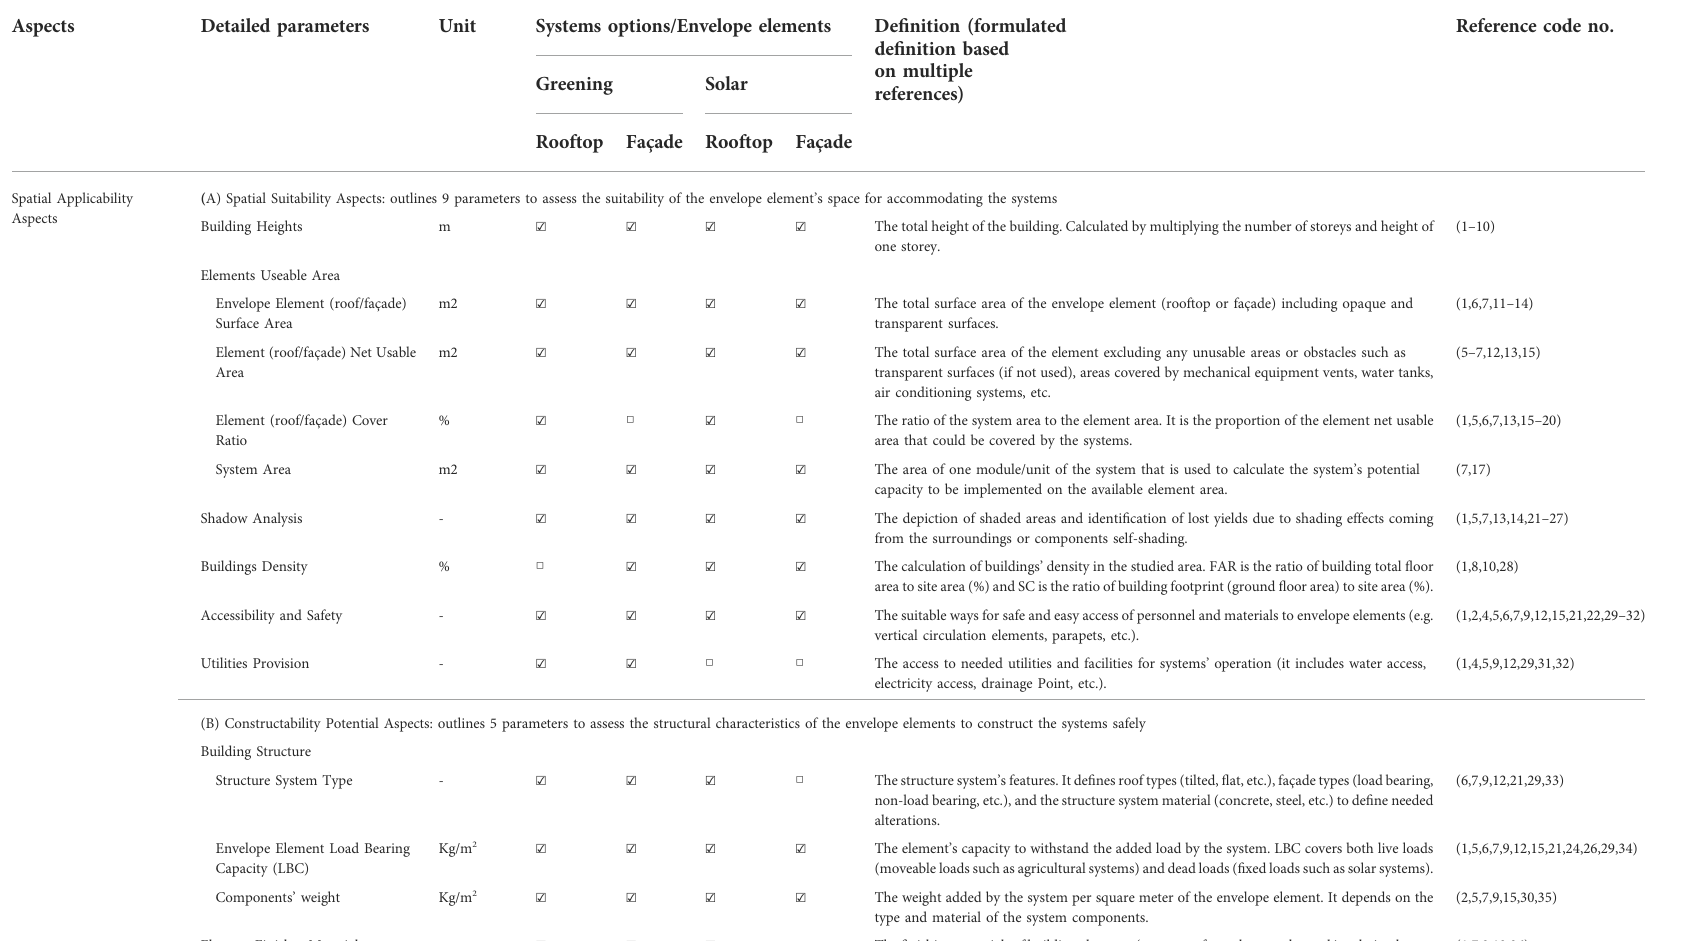
TABLE 1Pillar 1 ofapplicability aspects for PBSs Implementation mappedagainst systems ’ options (greening or solar) on different envelope elements (rooftop orfaçade). Detailed aspects and parameters were de fi ned for each category, the measurement units, and the de fi nitions are outlined as well. FAR, Floor Area Ratio; SC, Site Coverage; LBC, Load Bearing Capacity; DLI, Daily Light Integral; PAR, Photosynthetically Active Photons. List of References corresponding to the reference code numbers is in Supplementary Table S4.